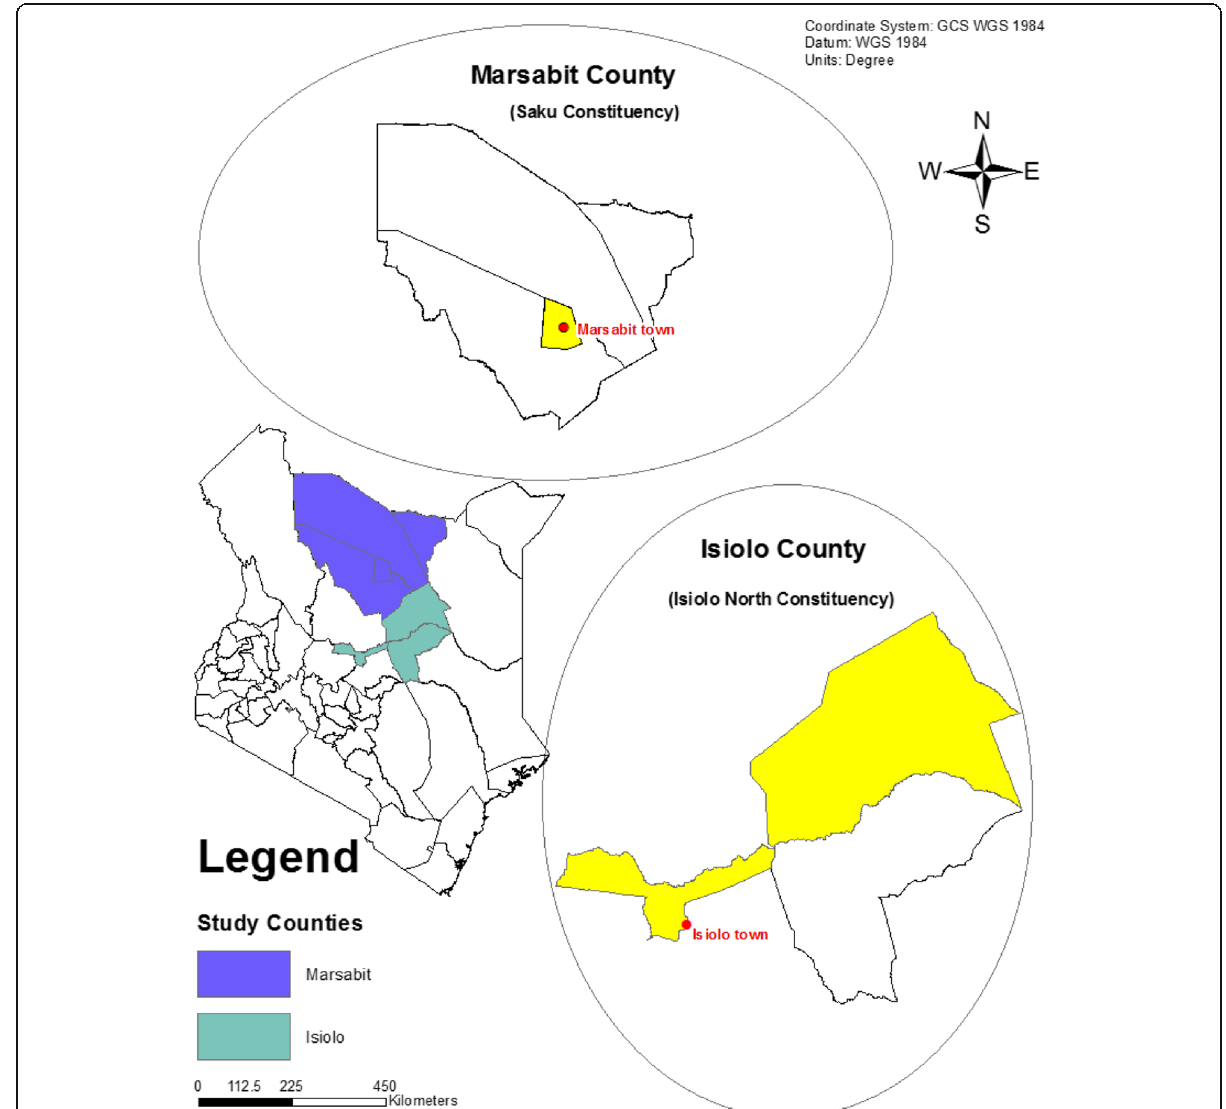
Fig. 1 Study regions where koche processing is practised in